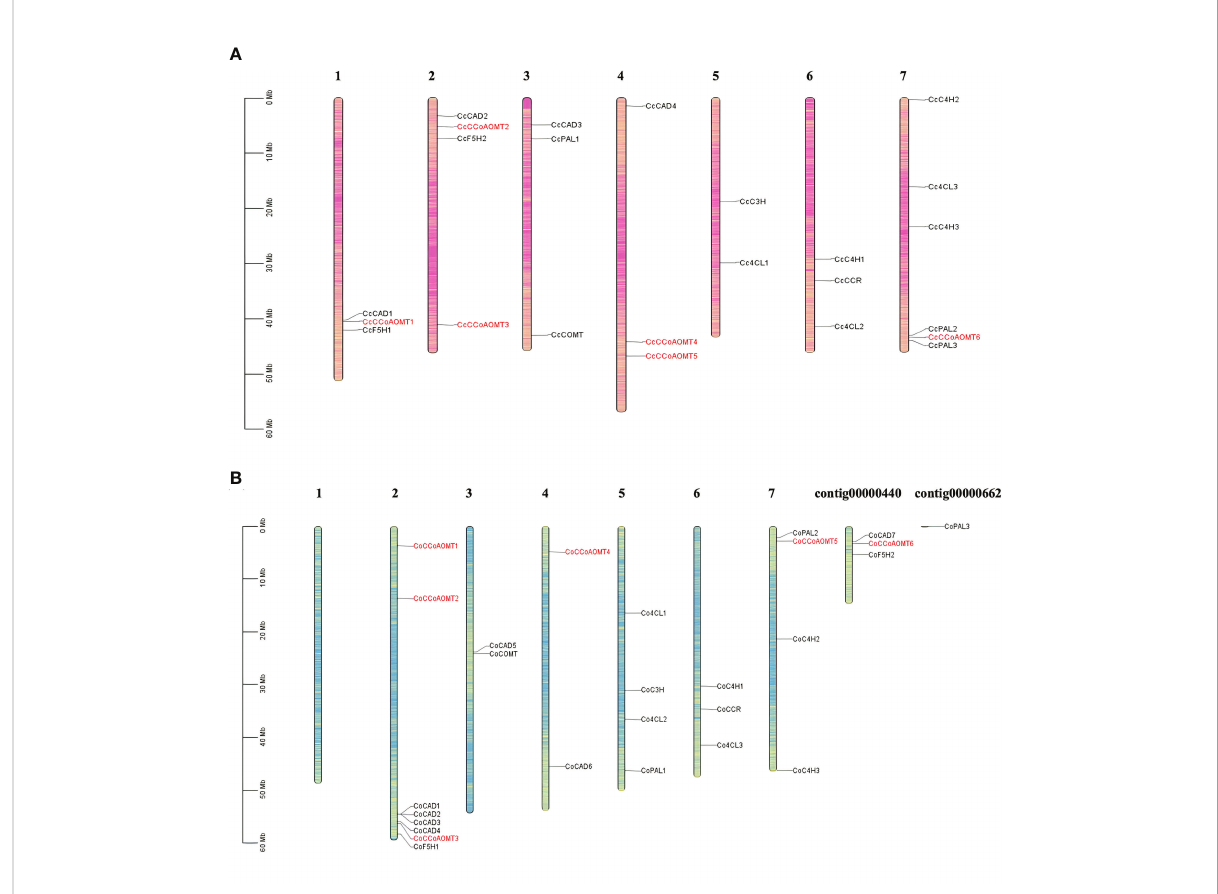
FIGURE 3 Distribution of the gene members involved in lignin biosynthesis of both C capsularis and C olitorius species. The CCoAOMT genes are indicated in red. Rest of the gene family members are marked in black. Each gene member pointed to the exact position of a speci fi c chromosome, which could be estimated using the scale on the left. The scale in Megabase is represented by the left bar (Mb). Chromosome numbers are provided at the top of each chromosome bar. (A) Chromosomal localization of 6 CcCCoAOMT genes on 4 C capsularis chromosomes. (B) Chromosomal localization of 6 CoCCoAOMT genes on 3 C olitorius chromosomes and 1